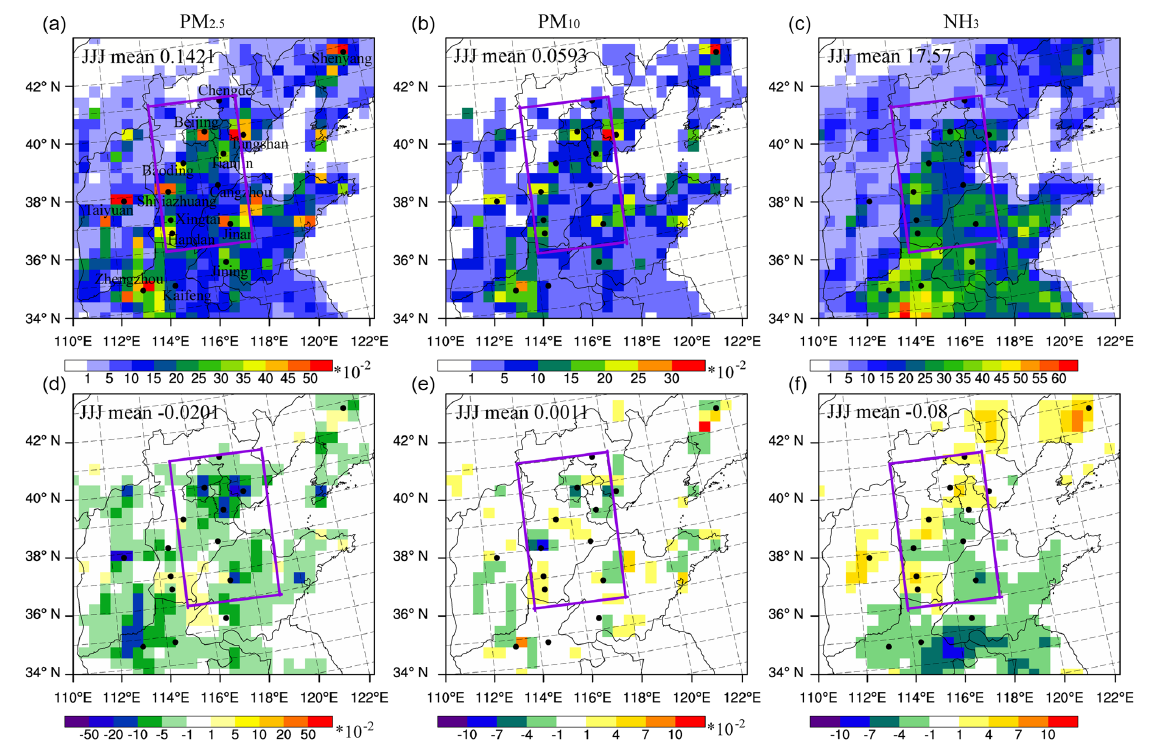
Figure 8. Spatial distribution of the prescribed emissions (top panels) of PM 2 . 5 (a, d) , PM 10 (b, e) , and NH 3 (c, f) and the corresponding time-averaged differences between the ensemble mean analysis and the prescribed values at the lowest model level averaged over all hours from 6 to 16 October 2014 in the NCP region. Units for PM 2 . 5 and PM 10 emissions: µgm − 2 s − 1 ; units for NH 3 emissions: molkm − 2 h − 1